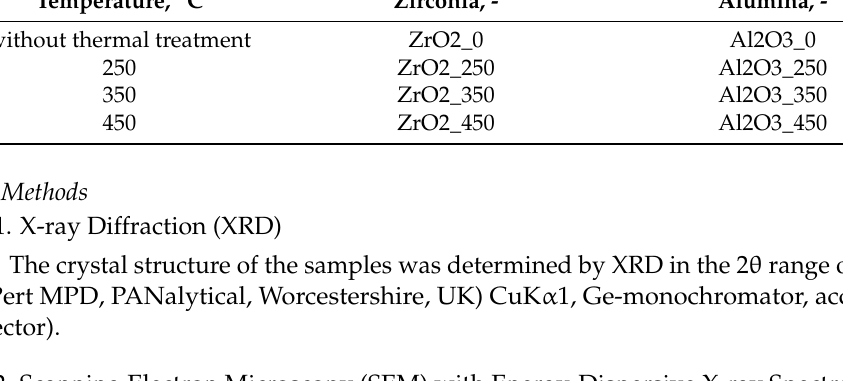
Table 1. Description of etched, APTES-modified, and heat-treated samples. Temperature, ◦ C Zirconia, - Alumina, - without thermal treatment ZrO2_0 Al2O3_0 250